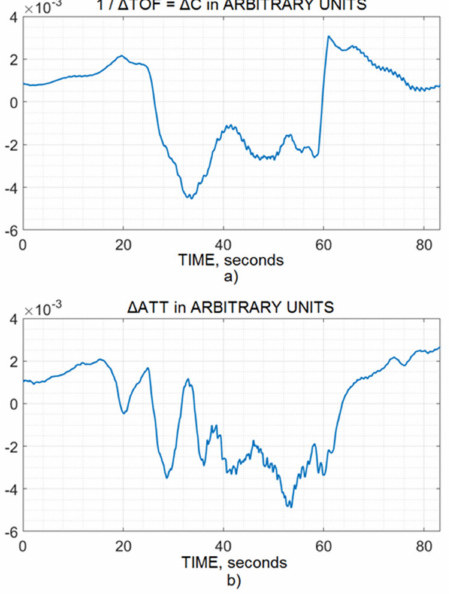
Figure 2. Vasoconstriction dynamics of intracranial blood vessels caused by hyperventilation test and recorded by ( a ) the time-of-flight and ( b ) attenuation channels of the ultrasonic noninvasive CA